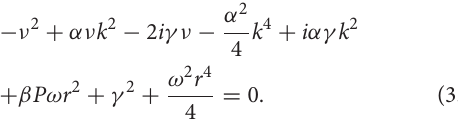
tan 2 (0.02 t ), (C) δ ( t ) = 0.5cos t ), and α +